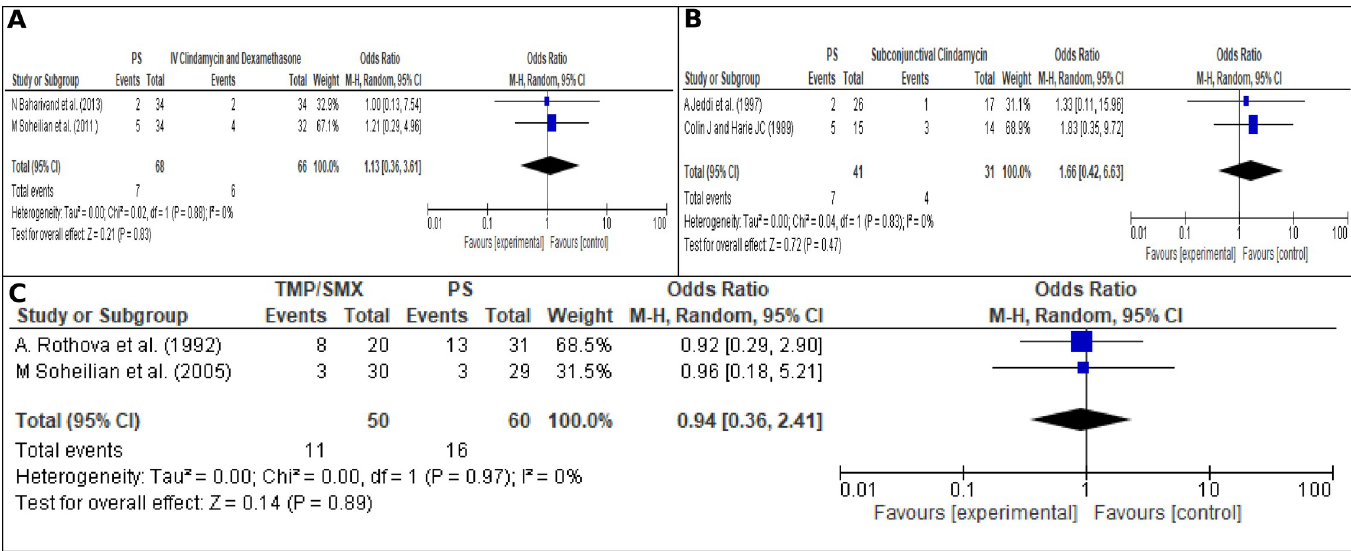
Fig 8. Effect of the treatment on the recurrences and visual factor. (A). Any scheme of P+Sdz vs Intravitreal clindamycin + dimethazone, (B). Any scheme of P+Sdz vs Subconjunctival clindamycin, (C). Any scheme of TMP/SMX vs Any scheme of P+Sdz.